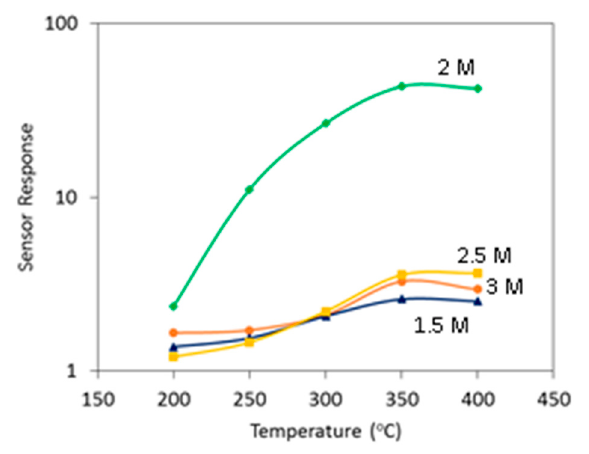
Figure 5. Response vs. operating temperature of 2D WO 3 nanostructures prepared by anodization with different HNO 3 concentrations at 1 vol % H 2 .